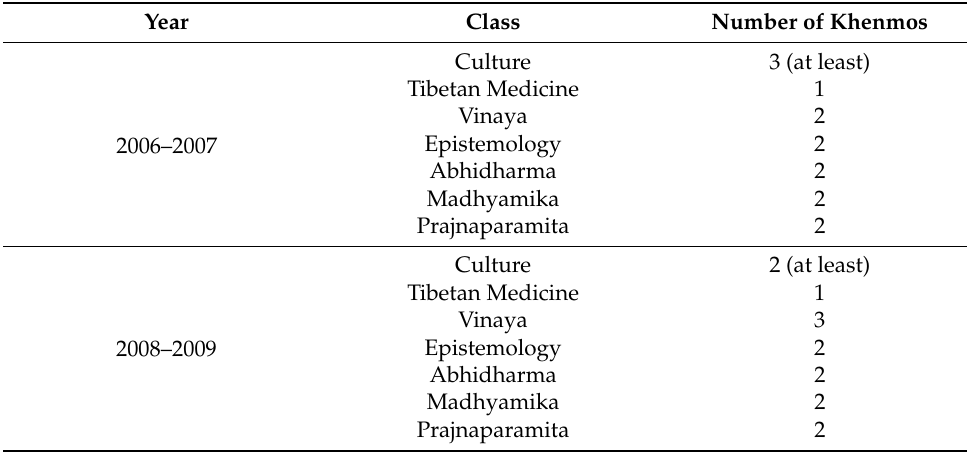
Table 2. The number of Khenmos and the curriculum from 2006 to 2009.